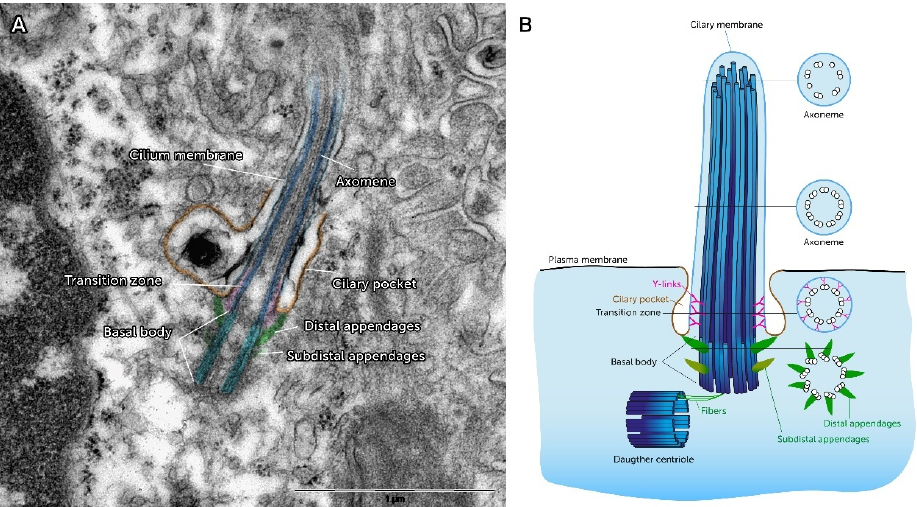
Figure 2. Structural features of Primary Cilia ( A ) Color-coded original electron microscopic image of a longitudinal section of a primary cilium show the typical structure of these cell organelles: basal body in bright blue, axoneme in dark blue, distal appendages in green, the transition zone in pink and the ciliary pocket in orange. (scale bar 1 µm). ( B ) The schematic image of the primary cilium gives information about the change of the cross-sectional structure in the course of the ciliary